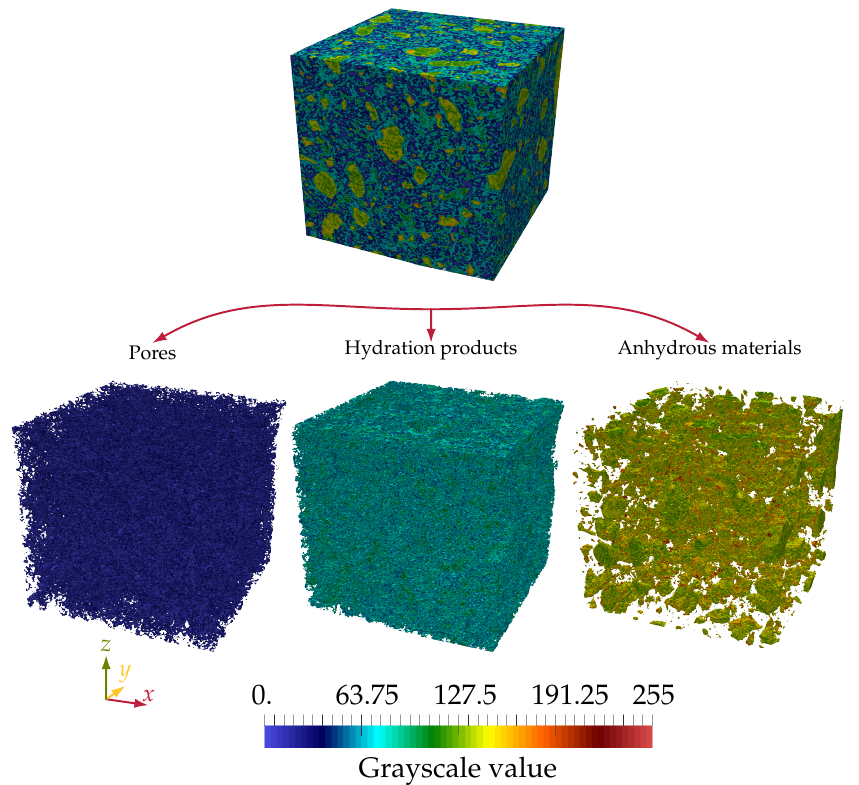
Figure 6. The hydrated cement sample pt045_sld_7dv1c300 [43,44]. A core cube of dimensions 300 300 300 µ m 3 was taken as a representative element volume. Three phases (pores, hydration × × products, and unhydrated cement) were obtained using Power’s model [45] (Equation